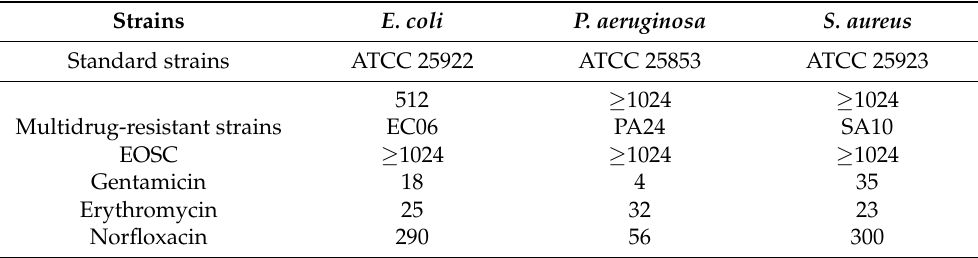
Table 2. Minimum inhibitory concentration ( µ g/mL) of the S. cumini EO against the standard multidrug-resistant